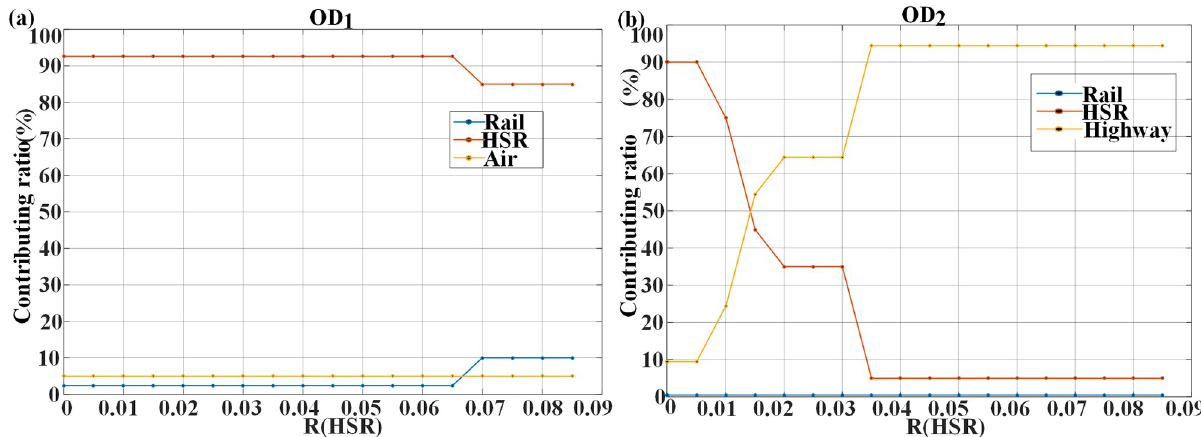
Fig 4. Impact of high-speed rail equilibrium return rate changes on mode structure (a) OD1; (b) OD2.